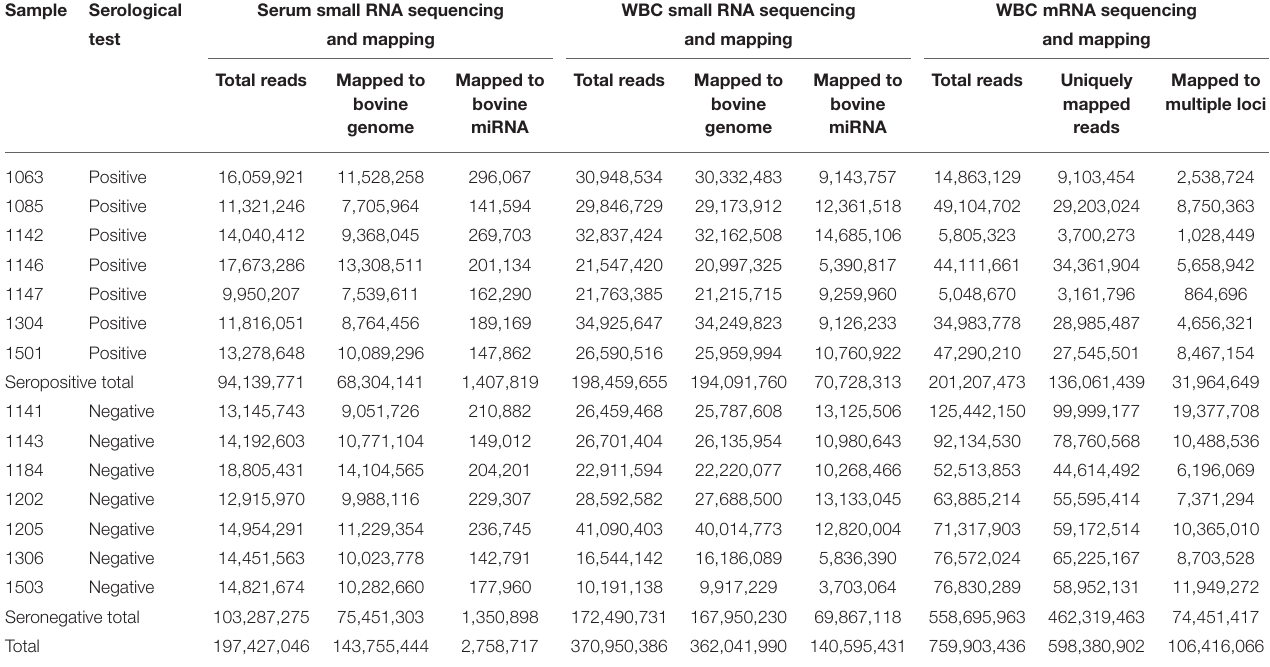
TABLE 1 | Sequencing and mapping statistics of small RNA and mRNA libraries.